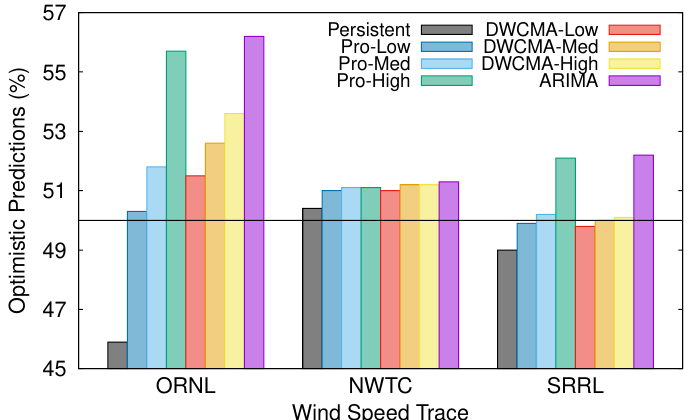
Figure 5. Percentage of optimistic